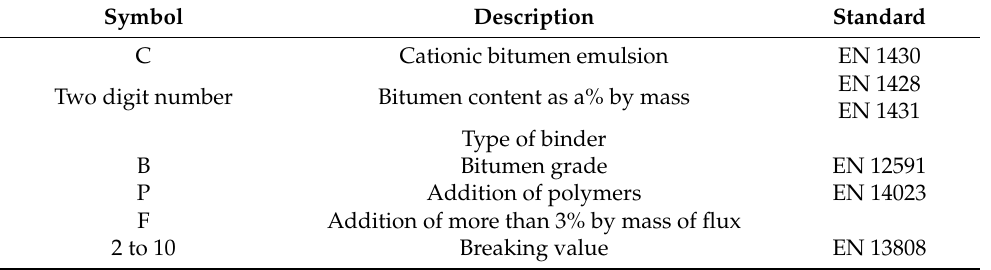
Table 1. Cationic emulsion abbreviated description adapted from [27].